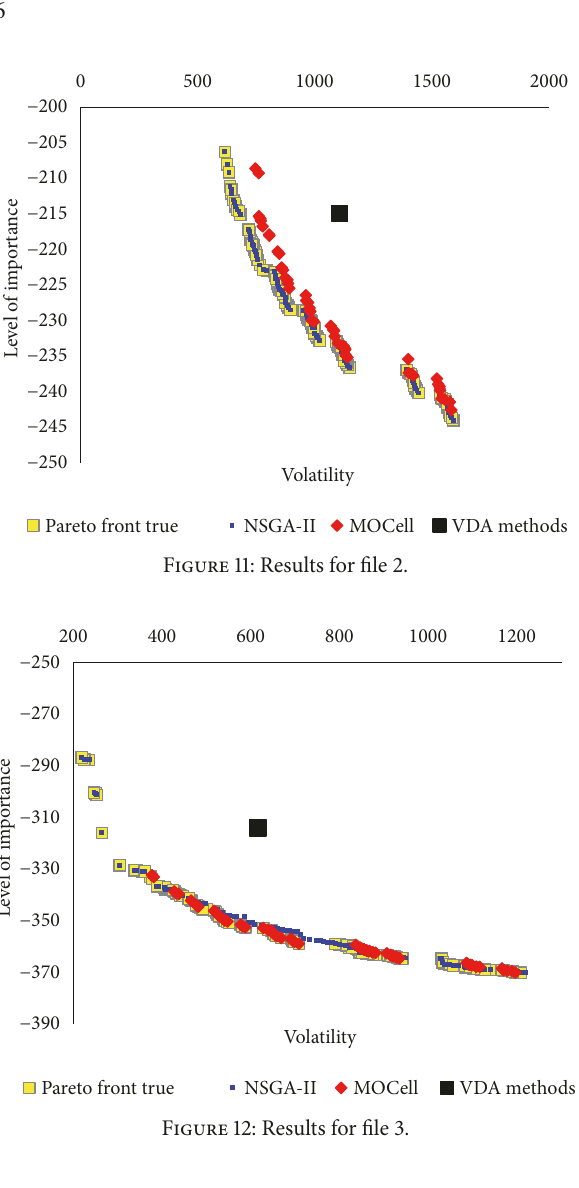
Figure 12: Results for file 3.